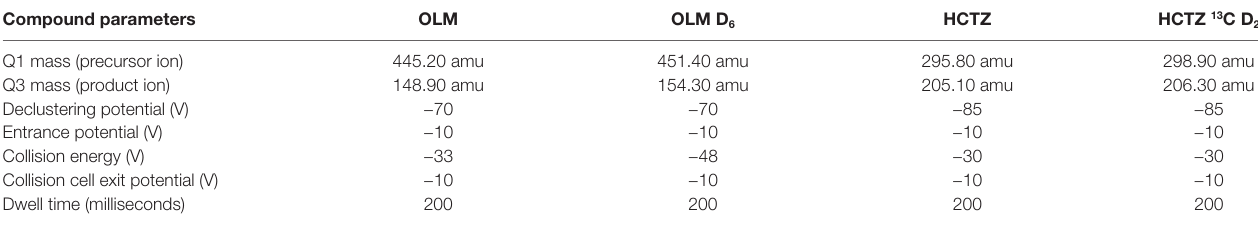
TABLE 1 | ESI-MS/MS compound parameters for OLM, OLM D 6 , HCTZ, and HCTZ 13 C D 2 .